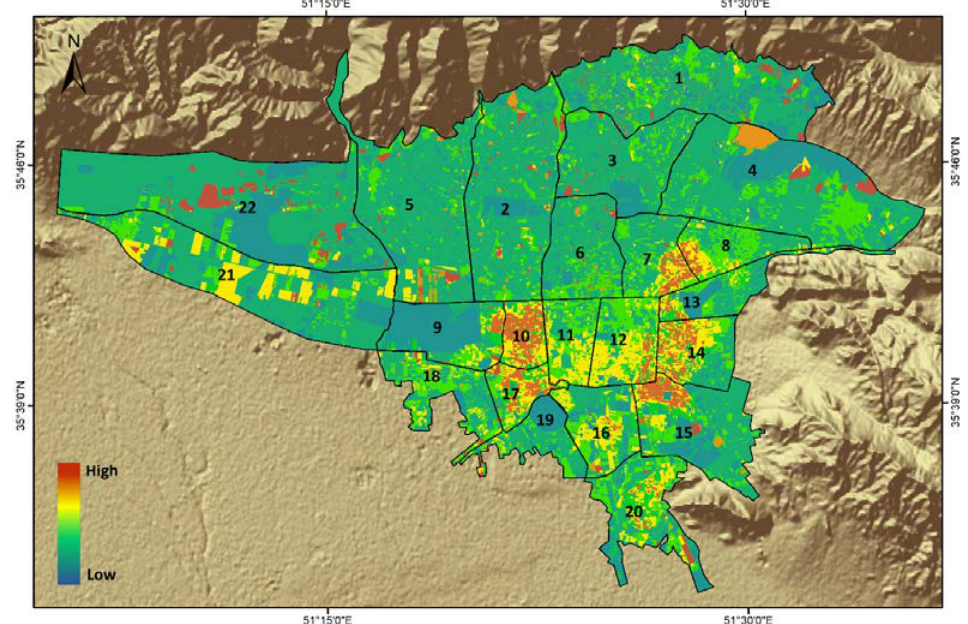
Figure 8. Overall physical vulnerability map of Tehran.